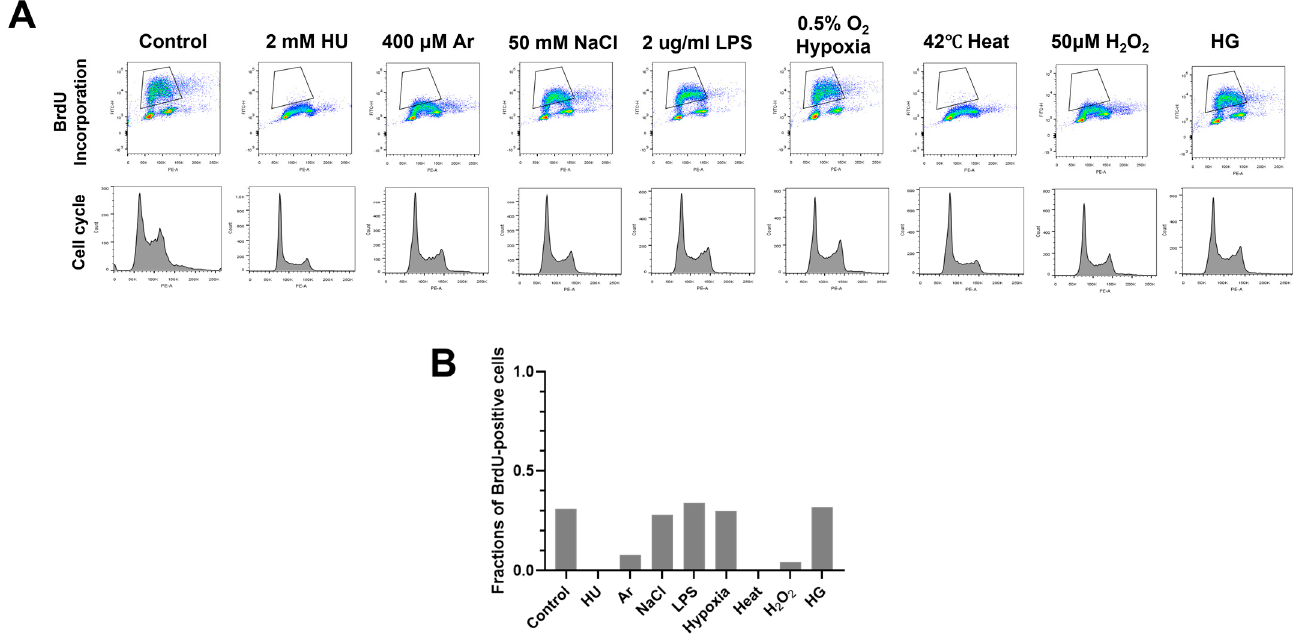
for each cell-cycle population. AU: arbitrary unit. ( F ) U2OS cells were exposed to different stresses for 3 h, and then were subjected to γ -H2AX (green), pChk1(S345) (red), and pRPA32 (S4/8) (phos- phorylated single-stranded DNA binding protein representing DNA damage) staining, together with flow cytometry analyses. For γ -H2AX (green) and pChk1(S345) (red), cells were observed under confocal microscopy (Zeiss LSM780). Representative data and images are shown. Scale bar is 10 µ m. ( G ) Quantification of the data from ( F , G ), fractions of γ -H2AX, pChk1(S345), or pRPA32 (S4/8)-positive populations are indicated for cells exposed to various stresses. Statistical analyses in ( D , E ) represent the mean values ± SEM under two independent experiments, all of which included